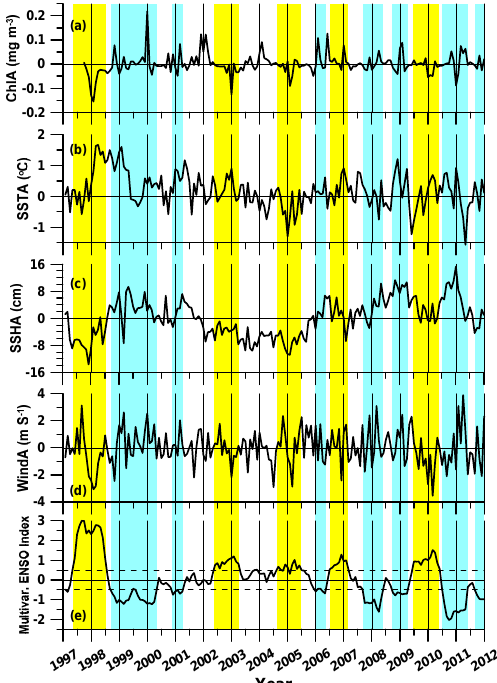
Figure 9. Non-seasonal variations (anomalies) of monthly mean values of environmental variables within the study area and the multivariate ENSO index (MEI): (a) sea surface chlorophyll-a concentration; (b) sea surface temperature; (c) sea surface height; (d) wind speed at 10 m above sea level; and (e) MEI. The ENSO events are marked as color stripes: El Niño events in yellow and La Niña in